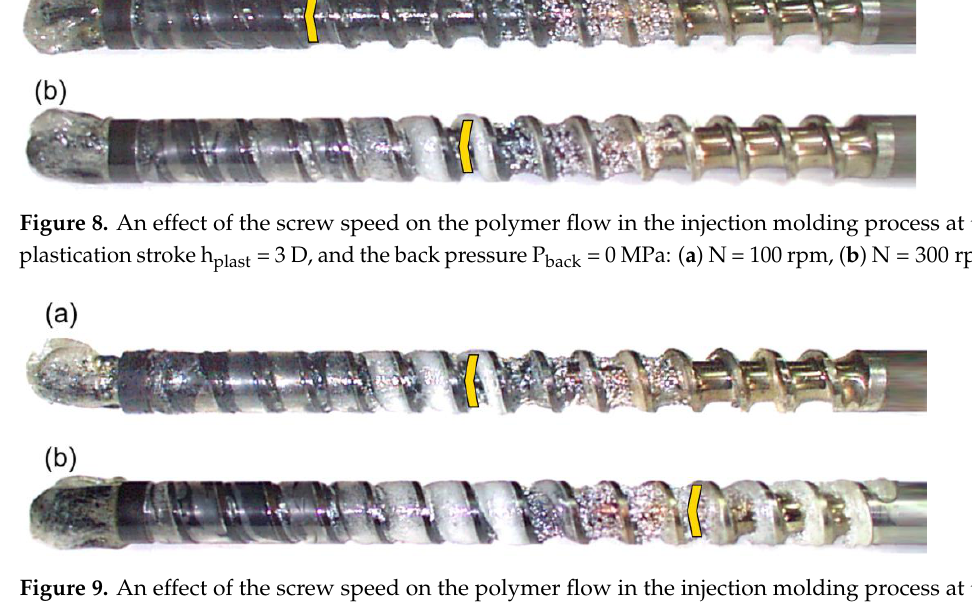
Figure 9. An effect of the screw speed on the polymer flow in the injection molding process at the plastication stroke h plast = 3 D, and the back pressure P back = 2 MPa: ( a ) N = 100 rpm, ( b ) N = 300 rpm.